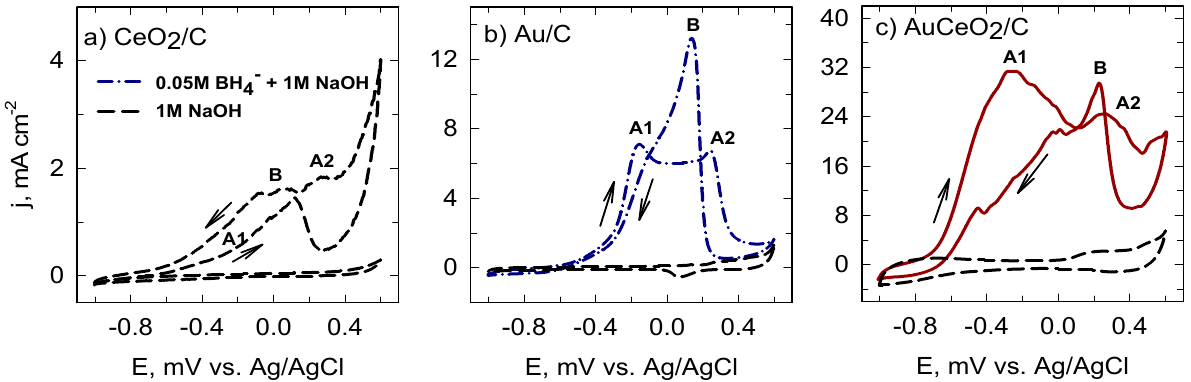
Figure 3. Comparison of cyclic voltammetry’s (CVs) of the investigated CeO 2 /C ( a ), Au/C ( b ) and AuCeO 2 /C ( c ) catalysts recorded in a 1 M NaOH and 0.05 M BH 4 ˉ + 1 M NaOH solutions at 50 mV s –1 ; 25 °C.